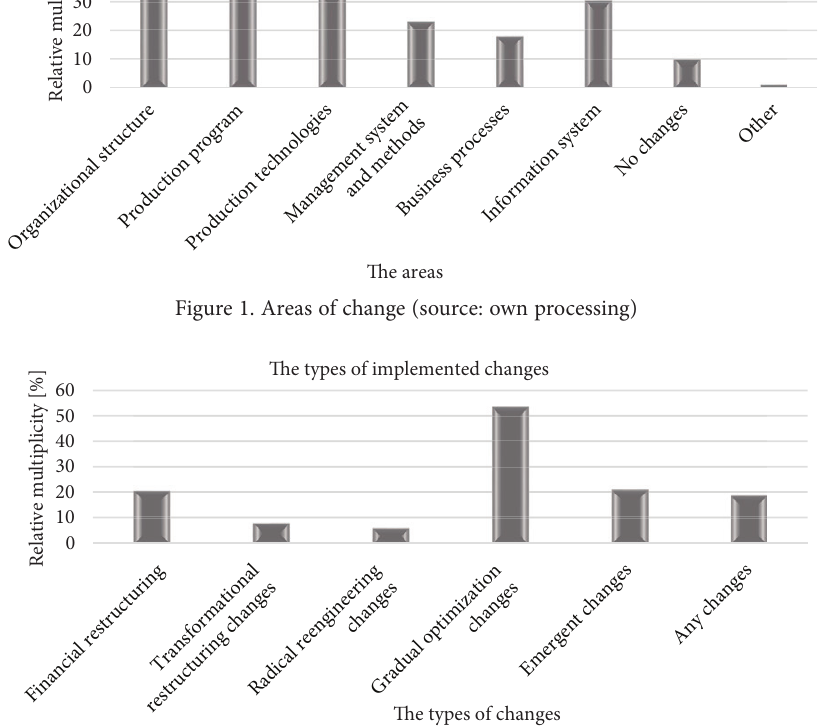
Figure 2. Types of changes (source: own